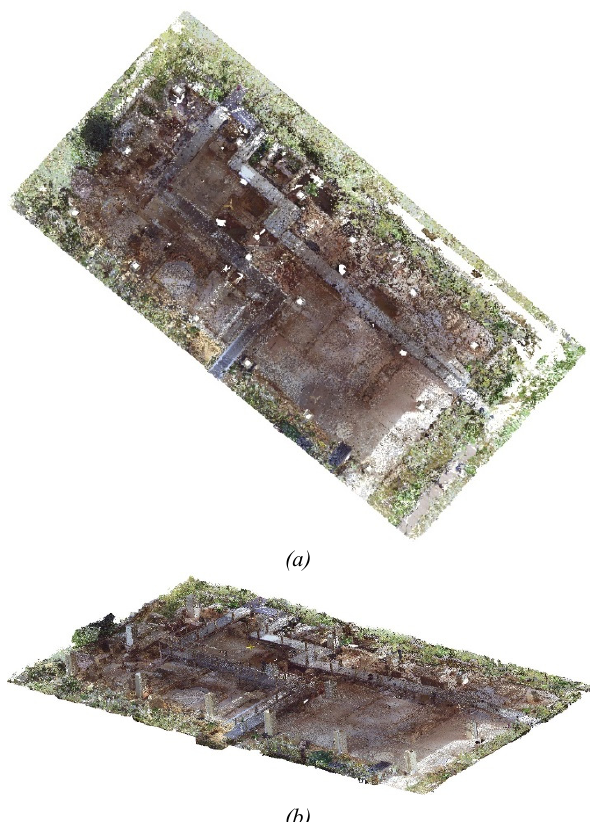
Figure 11. Subsampled point cloud of the Roman Domus : (a) plan view, (b) 3D view.